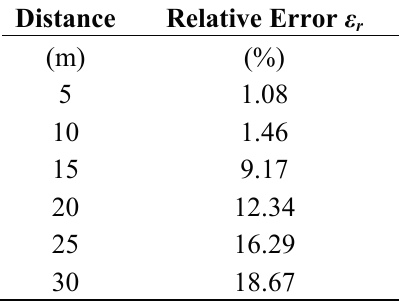
Table 3. Relative error of wirelessly transmitted signal